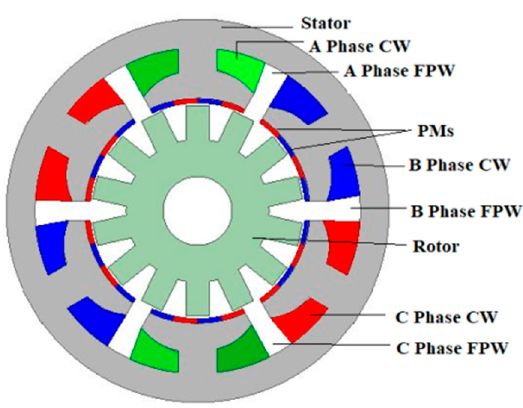
Figure 8. Cross-section of 3phase, 6/14 outer pole rotor FRM [24].